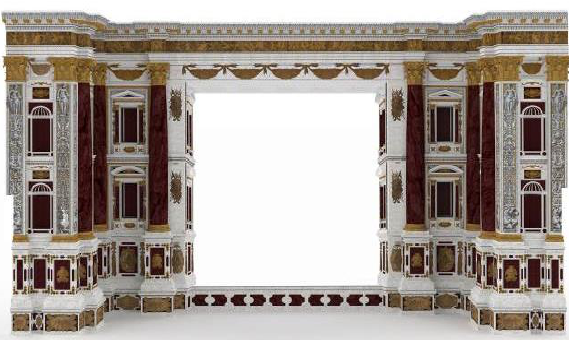
Figure 9 . Textured model with reconstruction of the original decoration of the proscenium.